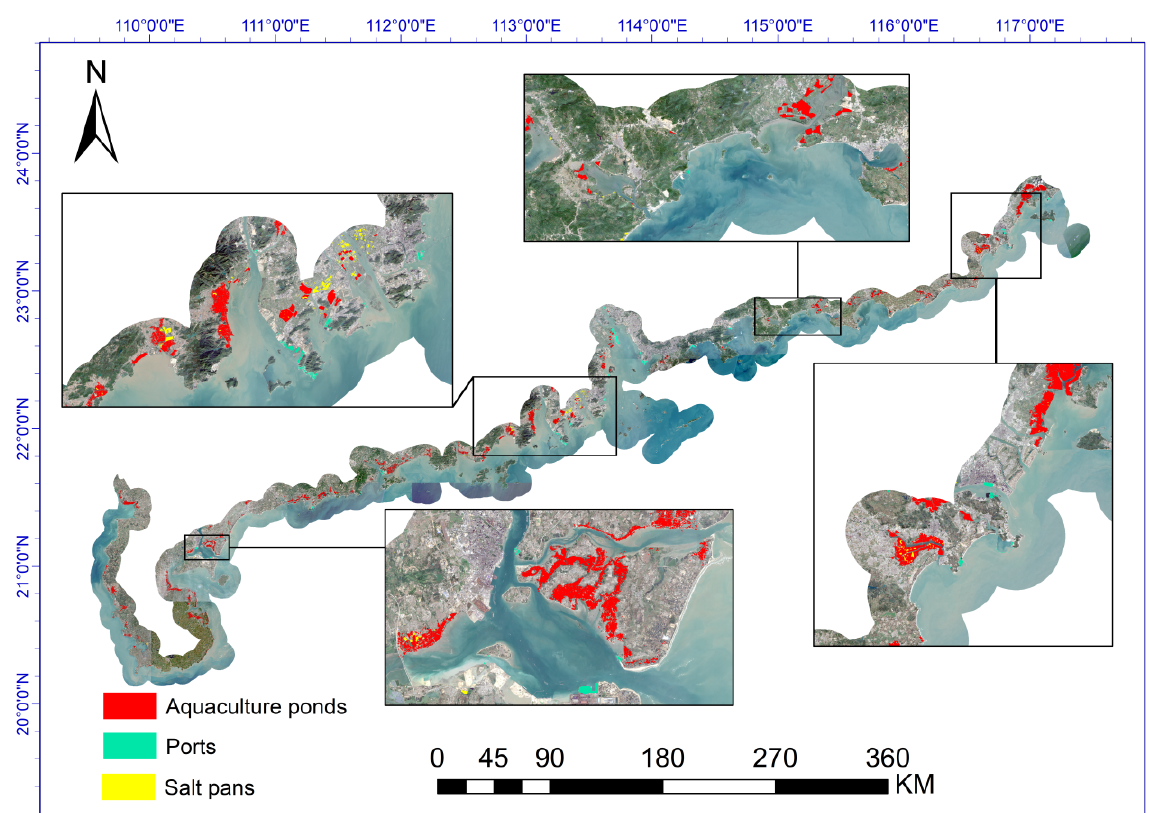
Figure 7. Spatial distribution of reclamation extracted from Sentinel 2A MSI images in 2018 over coastal Guangdong.